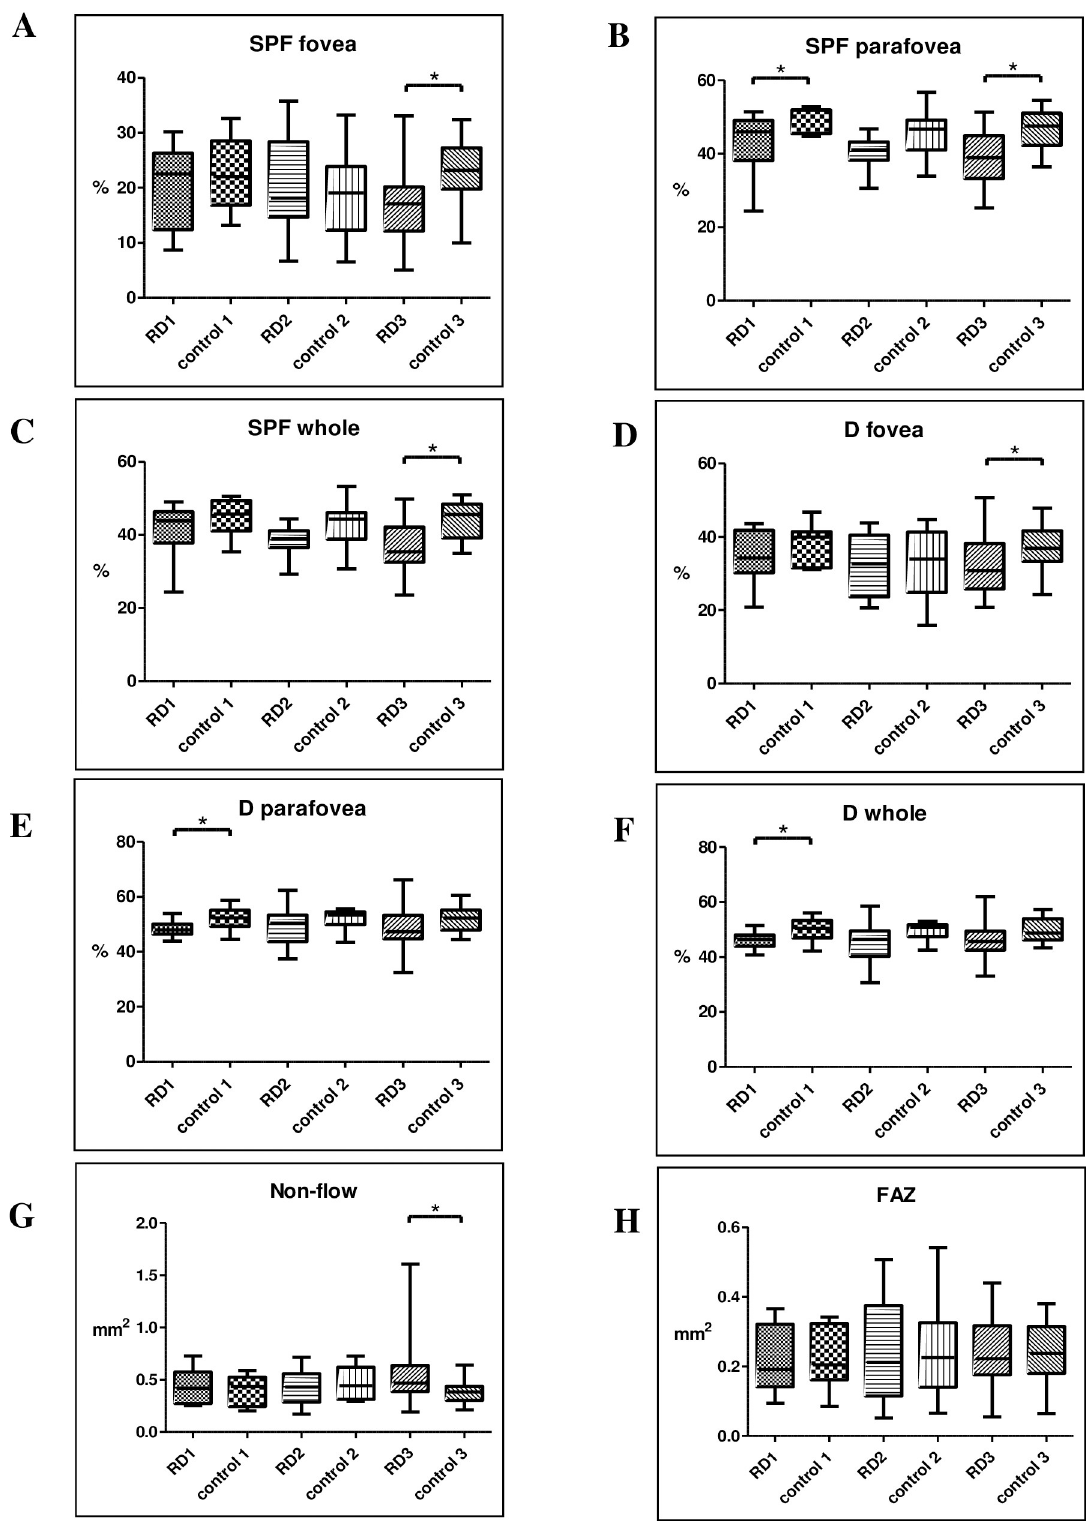
Fig 1. Diagram of the mean and SD of superficial (SPF, A-C) and deep retinal vascular density (D, D-F), non-flow area (G), and FAZ (foveal avascular zone, H) in all groups. Statistically significant differences between the groups are marked by an asterisk. � p < 0.05.